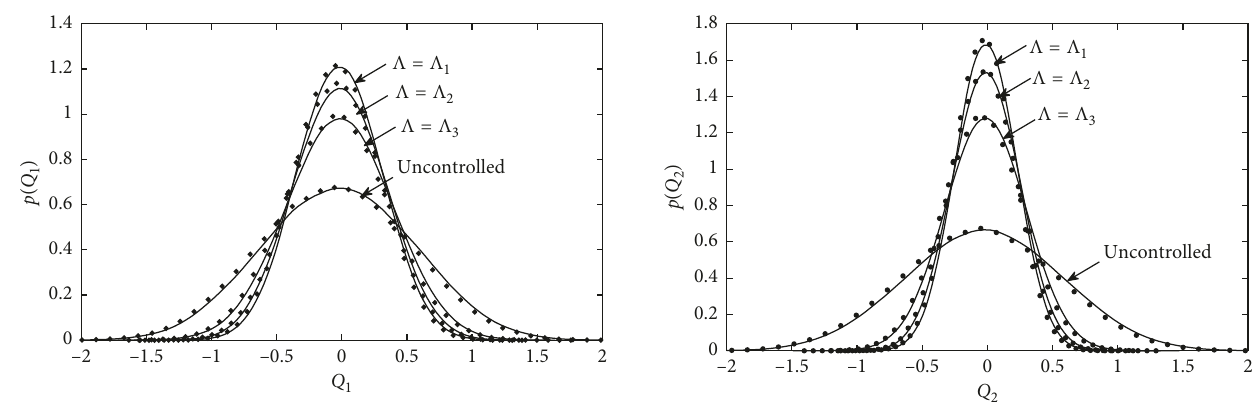
) of displacement 2